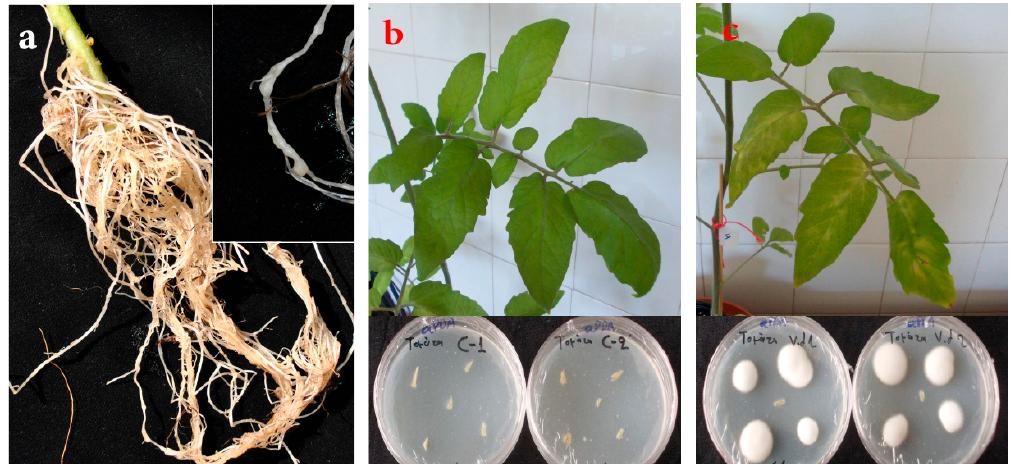
Figure 5. Visible knots on M. javanica -infected roots ( a ), and symptoms of V. dahliae infections in roots of control ( b ) and infected ( c ) tomato plants. In ( b , c ), bottom panels show Petri dishes from pathogen re-isolation.